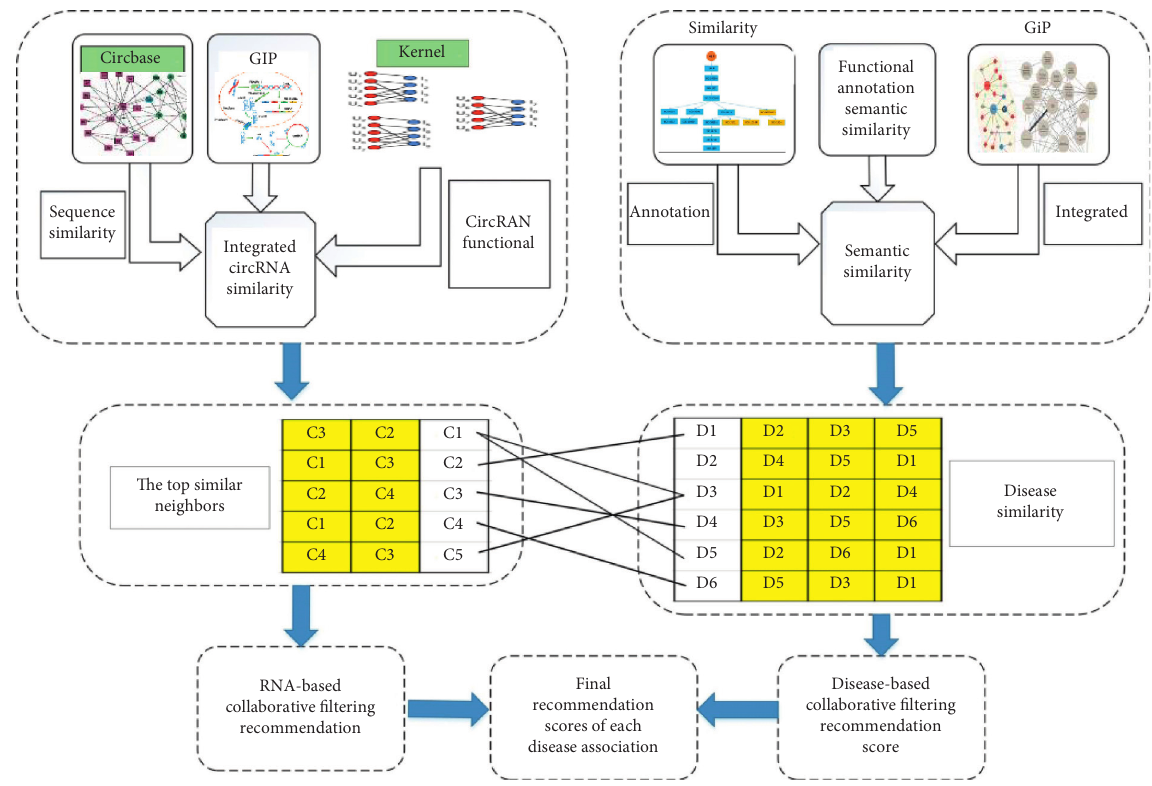
Figure 1: Improved collaborative filtering